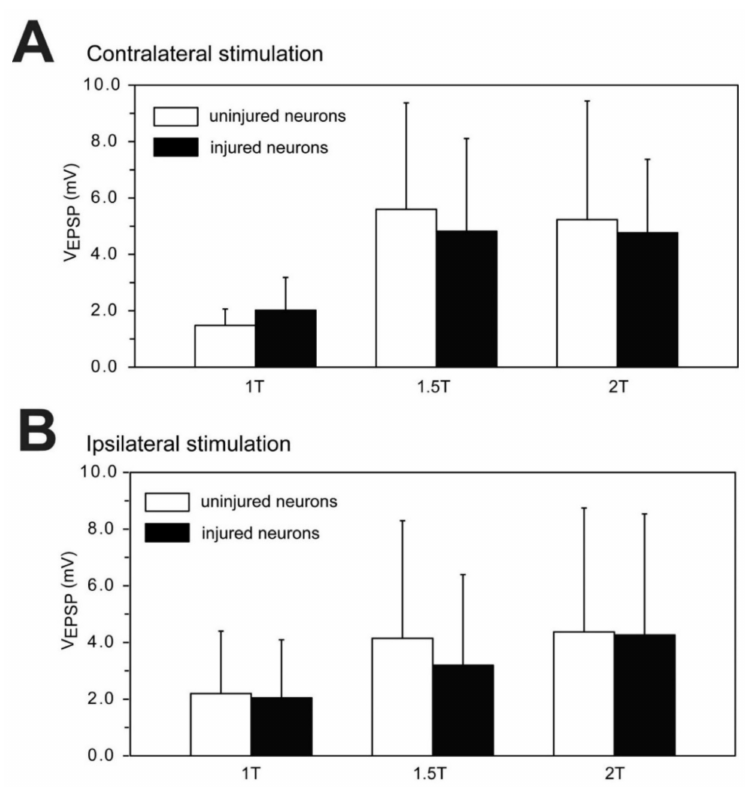
Figure 10. Amplitudes of sensory-evoked EPSPs are similar for uninjured and injured RS neurons. Average amplitudes (bars = means; vertical lines = SDs) of oral hood-evoked EPSPs for uninjured and injured pairs of RS neurons (n = 11 left-right pairs of RS neurons, N = 10 animals). ( A ) Average EPSP amplitudes evoked in uninjured (open bars) and injured (filled bars) RS neurons by contralateral stimulation of the oral hood at different stimulus intensities (1 T, 1.5 T, 2 T; see Methods). ( B ) Average EPSP amplitudes evoked by ipsilateral stimulation of the oral hood at different stimulus intensities. At each stimulus intensity for either contralateral and ipsilateral stimulation, the EPSP amplitudes were not significantly different for uninjured and injured RS neurons ( p = 0.20–0.94, see text; unpaired t -test, with Welch correction when appropriate; see